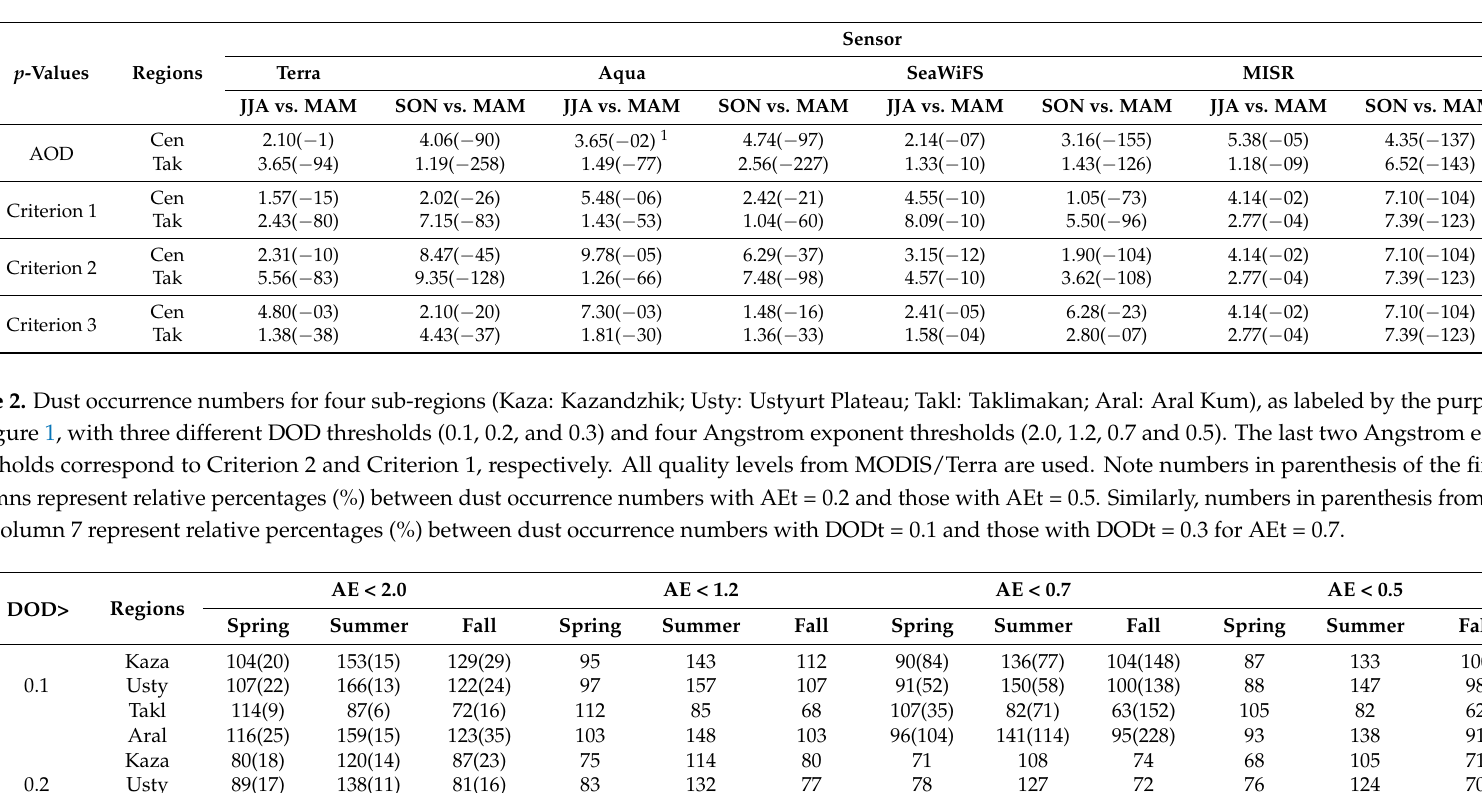
Table 1. p -values from the Wilcoxon sum rank test on AOD and DOD that derived using the three criteria, Criterion 1, Criterion 2, and Criterion 3, for the seasonal variation over the western Central Asia (Cen) and the Taklimakan Desert (Tak). The test is made using AOD/DOD with the quality flag 2 or 3; The superscript 1 shows test between MAM and JJA, rather than JJA and MAM (Note the order matters in the Wilcoxon sum rank test). Note for instance, 2.10( − 1) stands for 2.10 × 10 − 1 .